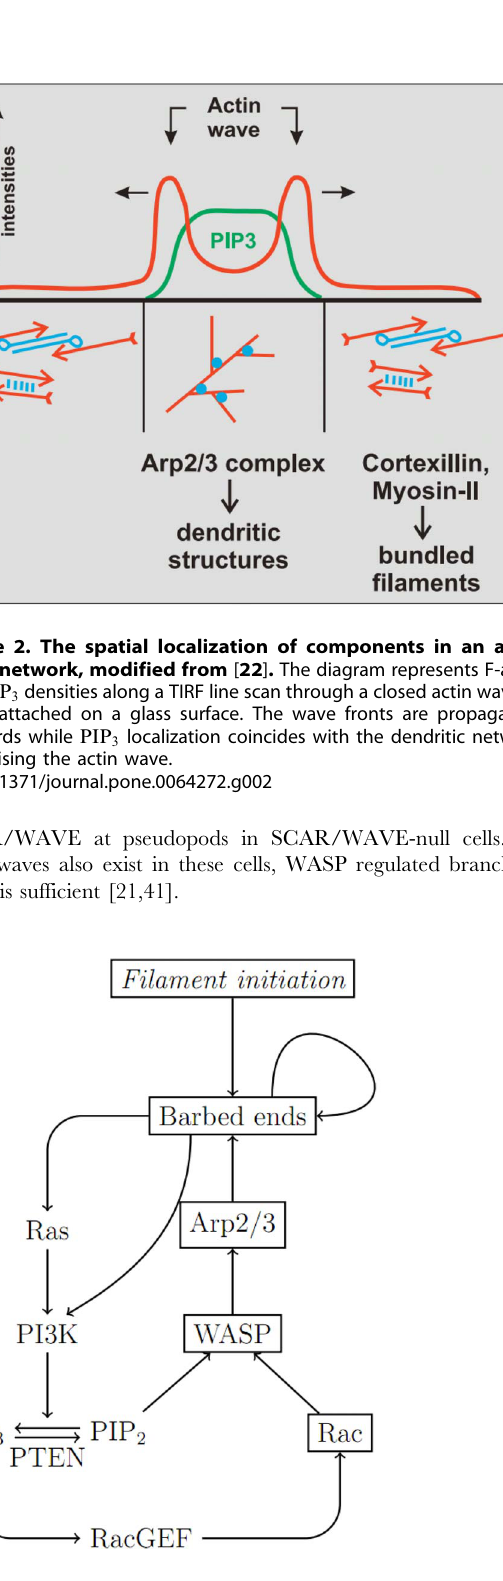
Figure 3. A simplified diagram for the feedback between F- actin and PI3K. This diagram shows regulation of molecular activity related to branching of actin filaments. Arrows represent activation, except for the conversion between PIP 2 and PIP 3 . The actin wave model developed herein describes the dynamics of boxed components, and the condensed network captures the essential features of wave propagation.